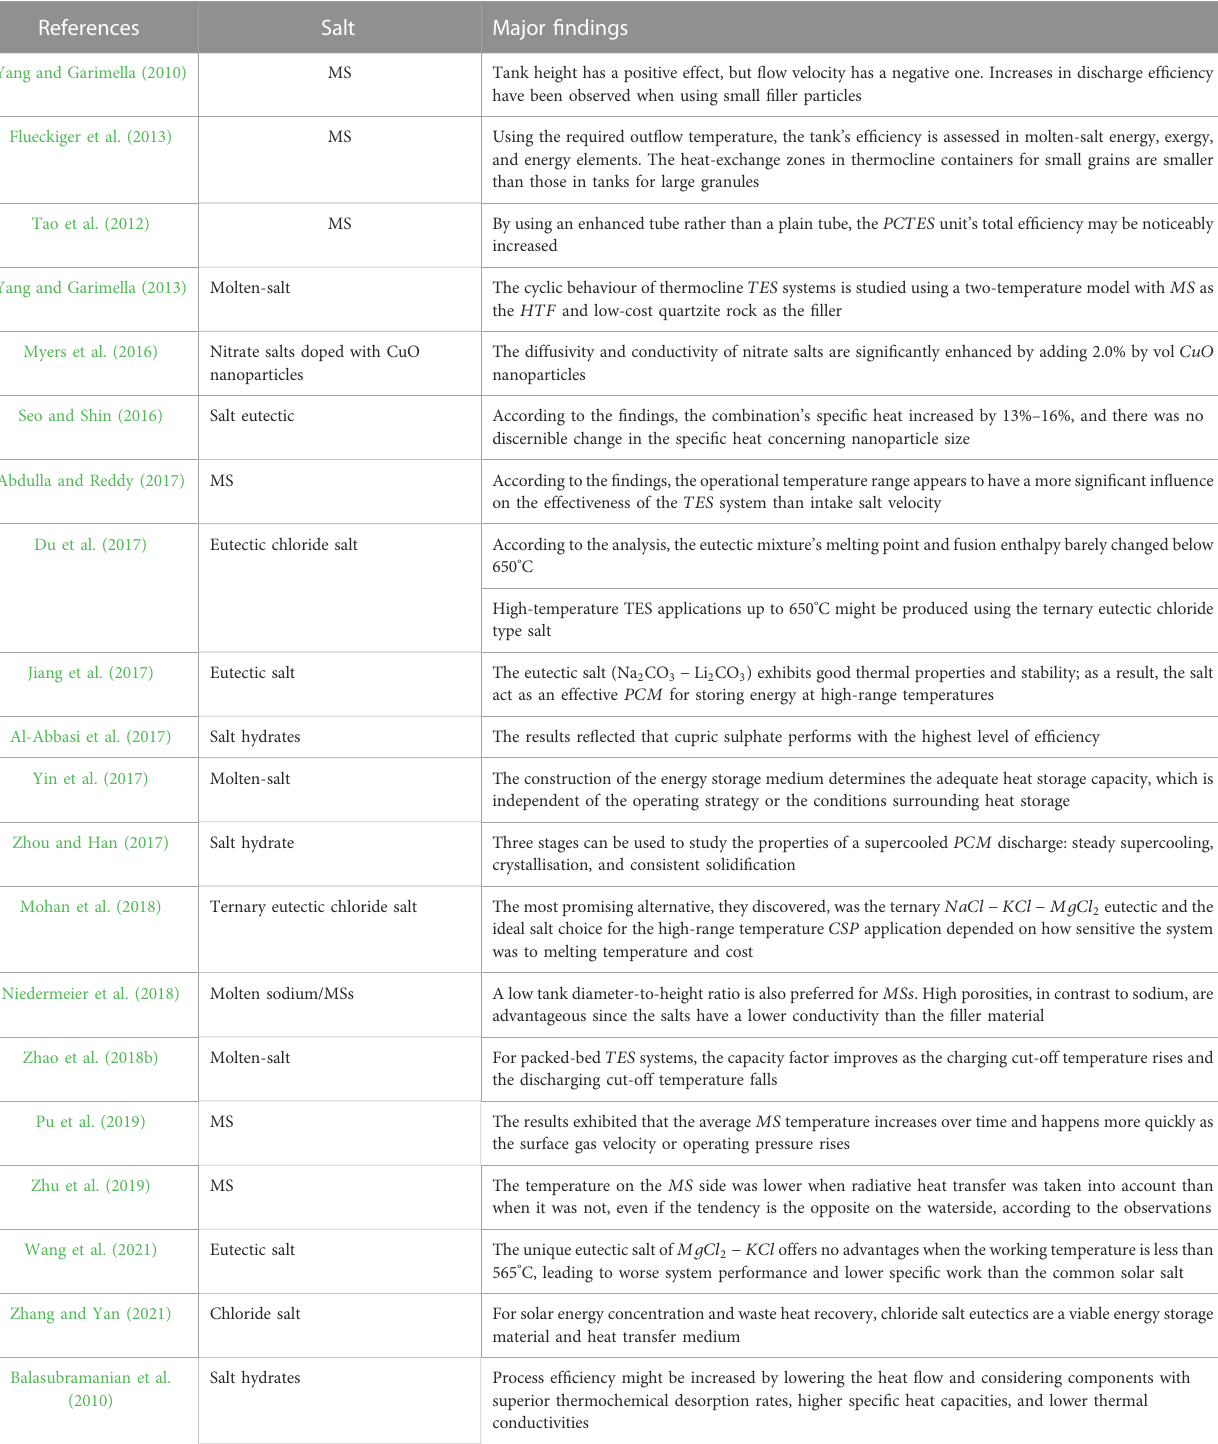
TABLE 2 Previous numerical analysis on TES system with salt as used storage